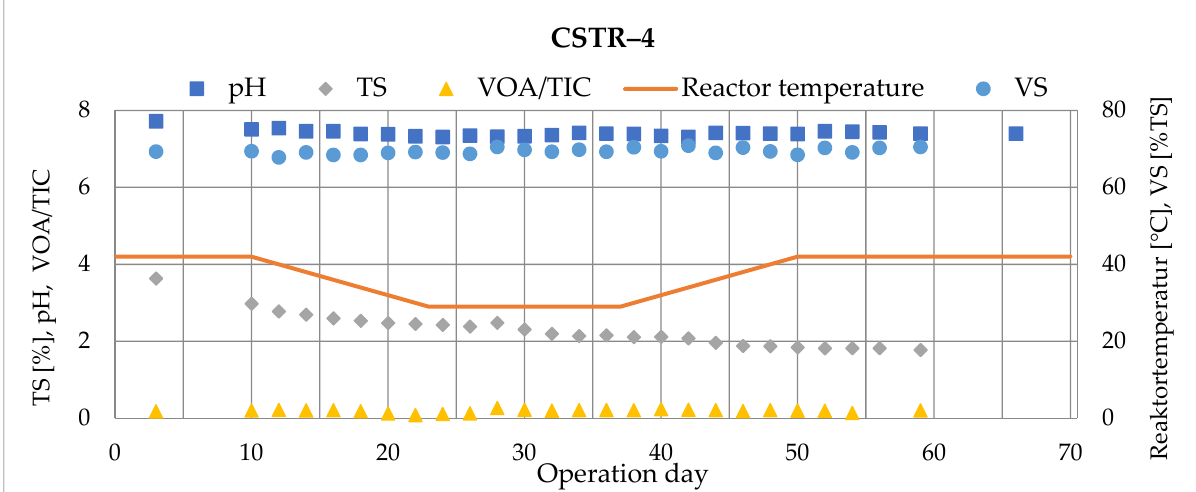
Figure 14. Laboratory analyses results of CSTR-4.